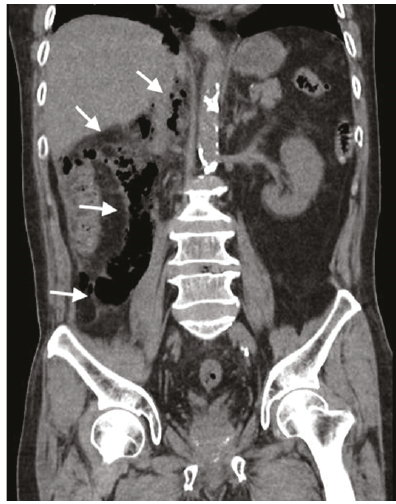
Figure 6: CT scan of abdomen illustrating extraluminal air outlin- ing the right kidney, psoas muscle, and diaphragmatic